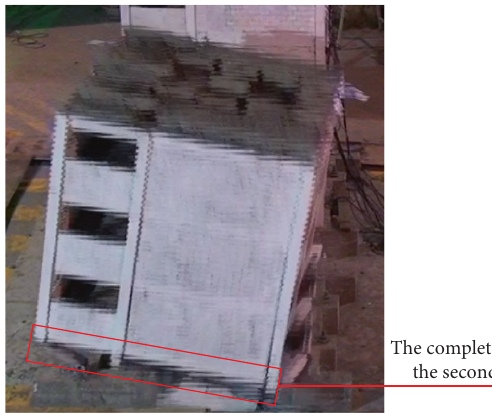
Figure 38: First-floor collapse of the test (right).